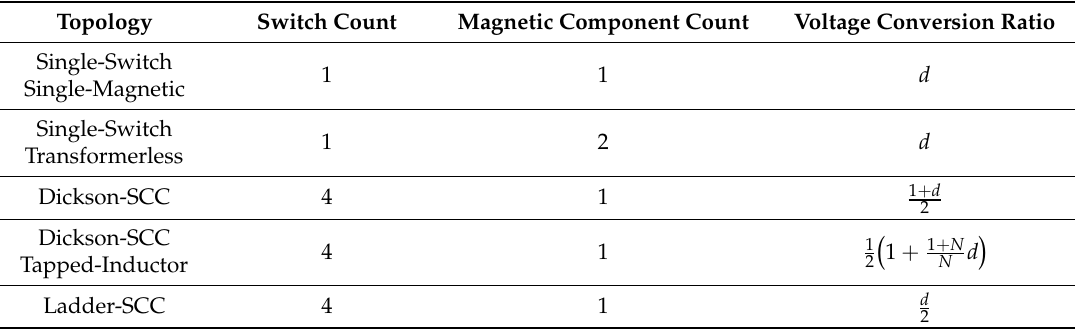
Table 1. Quantitative comparison for integrated PWM converters.